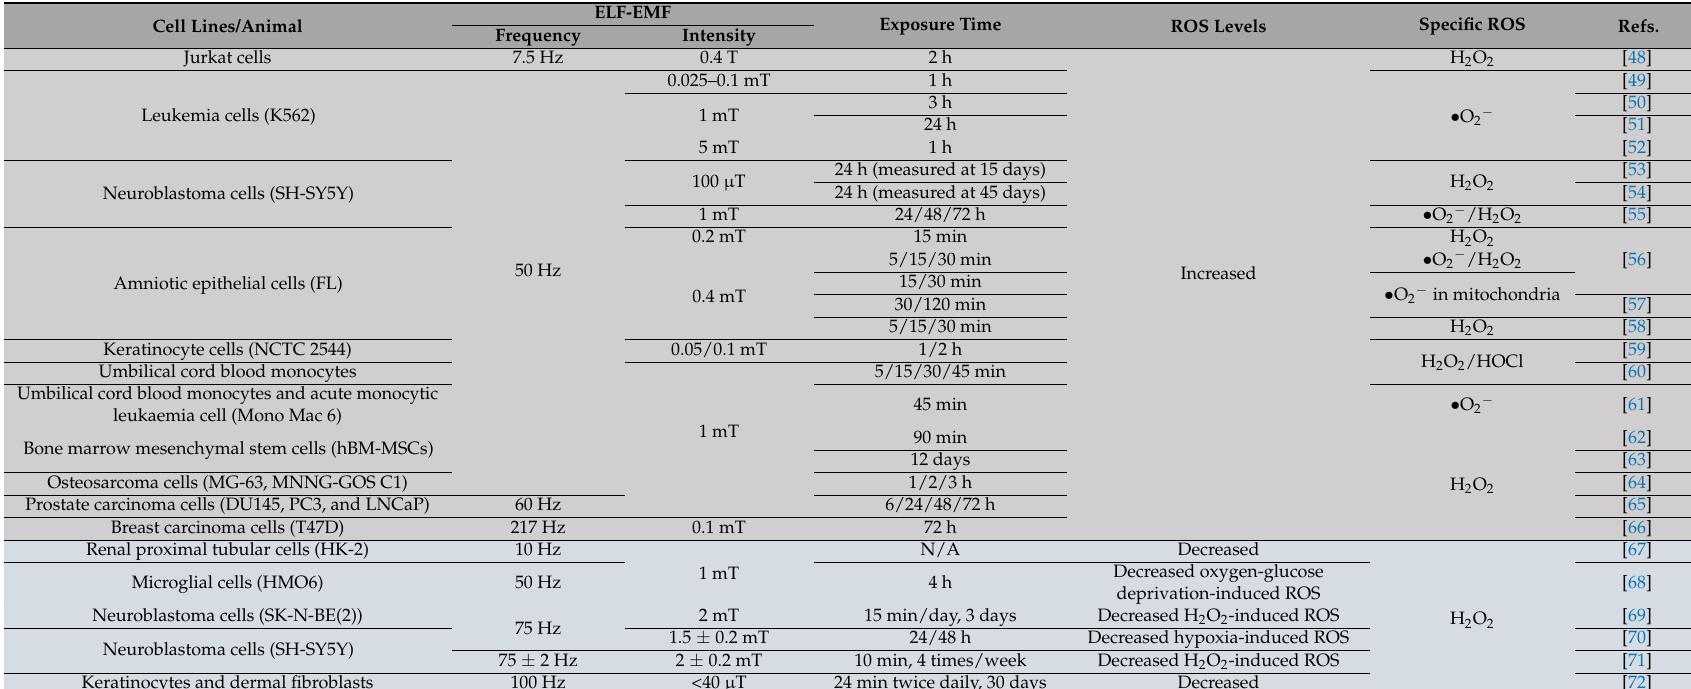
Table 2. ROS changes in human cells induced by extremely low frequency electromagnetic fields